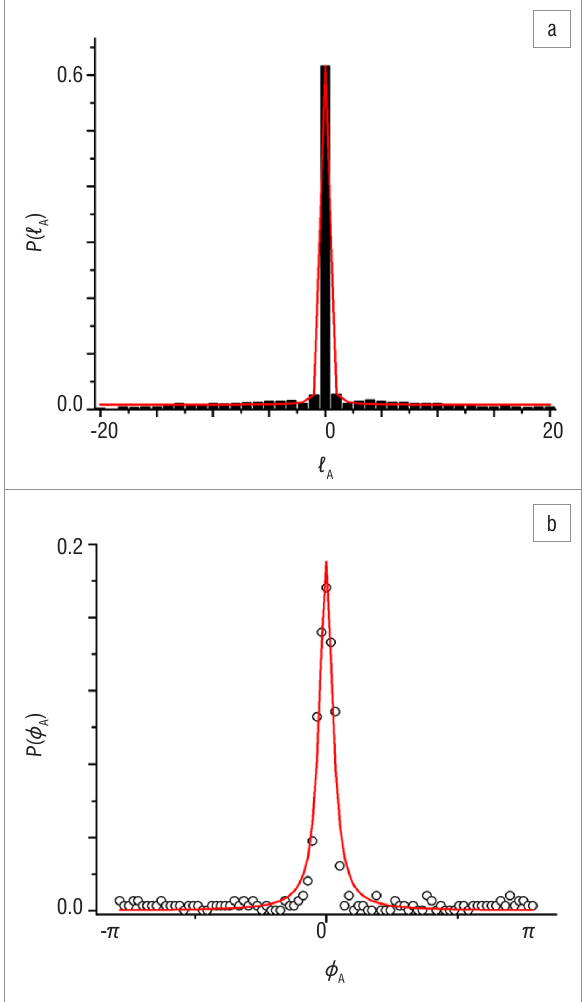
Figure 7: Probability distributions for (a) the orbital angular momentum for ℓ =0 and (b) the angular position ϕ ℓ A B